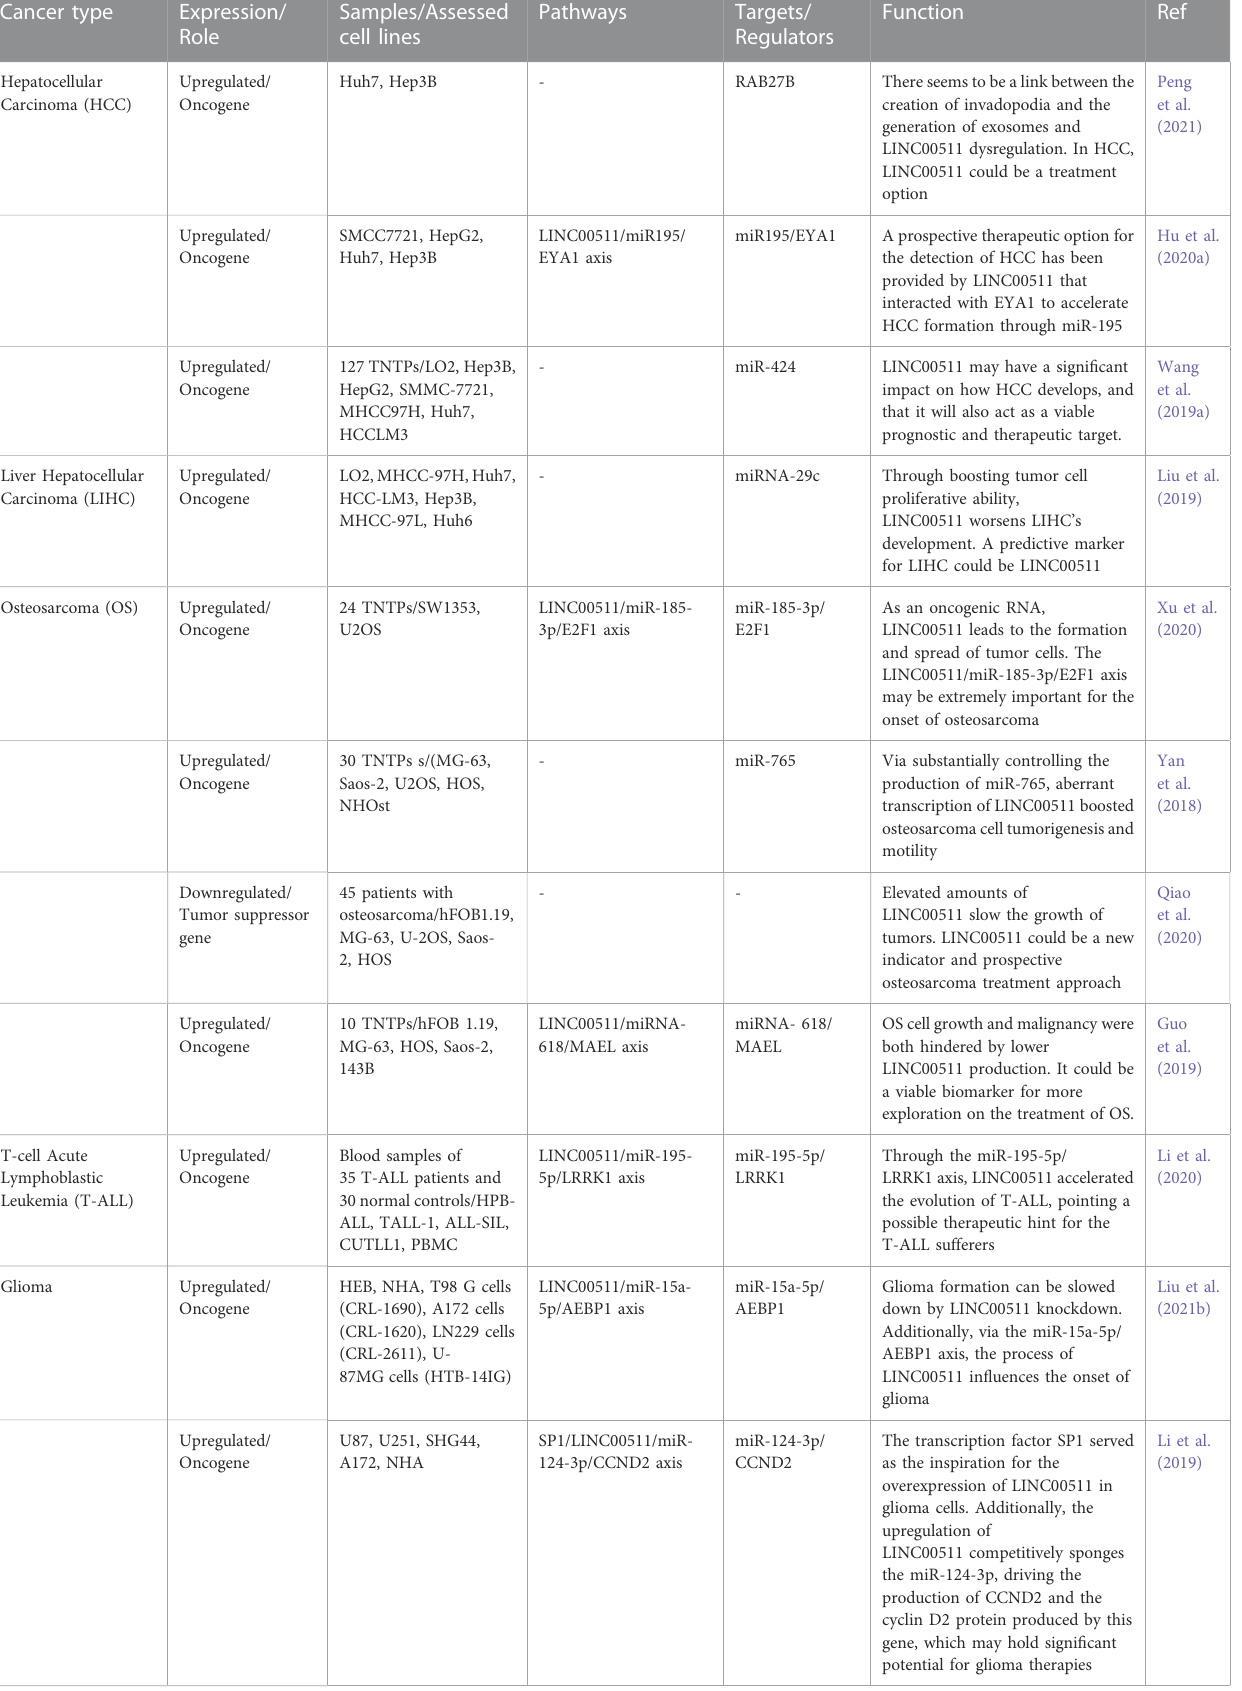
TABLE 4 Dysregulation of LINC00511 in different cancers (TNTP: tumor and non-tumor pairs of tissues). Cancer